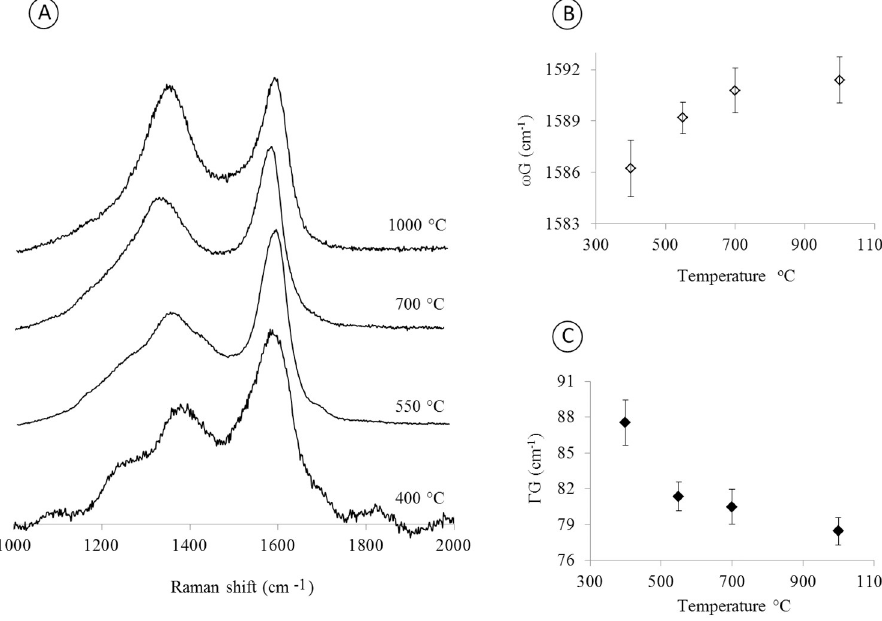
Fig 4. (A) Raman spectra of the charcoal samples obtained from the eucalyptus bark burned at temperatures from 400 to 1000 ˚C; (B) FWHM for the G-band as a function of the firing temperature; and (C) frequency of the G-band as a function of the charred